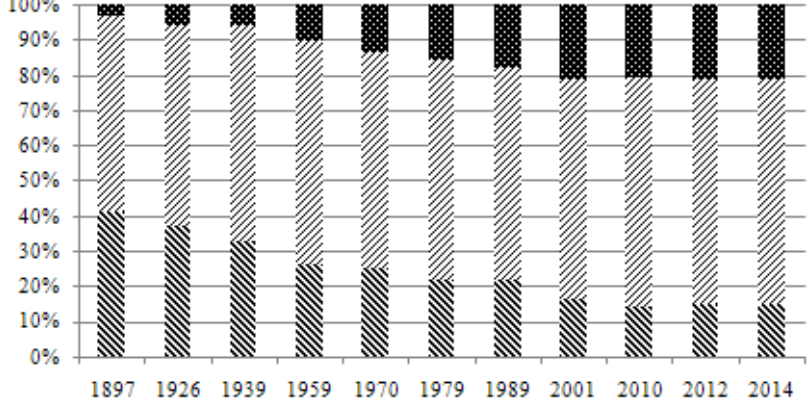
Fig. 3. Age structure of population of Ukraine for the period